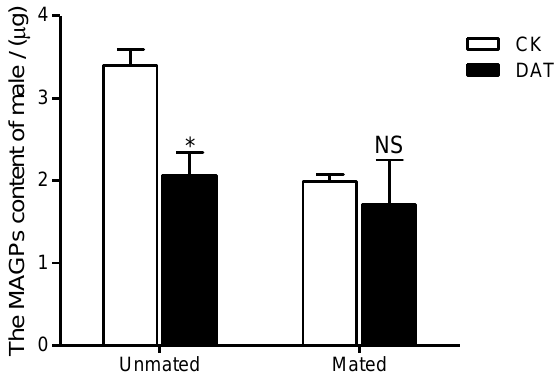
Figure 2. The male accessory gland protein (MAGP) content of males was determined in the CK group (at 19 h after emergence) and DAT group (males treated with 0.01% diallyl trisulfide for 7 h at 12 h after emergence) both before and after mating. The data in the figure are presented as the mean ± SEM. Asterisks depict significant differences relative to the control treatment (NS, no significant difference, *, p < 0.05).